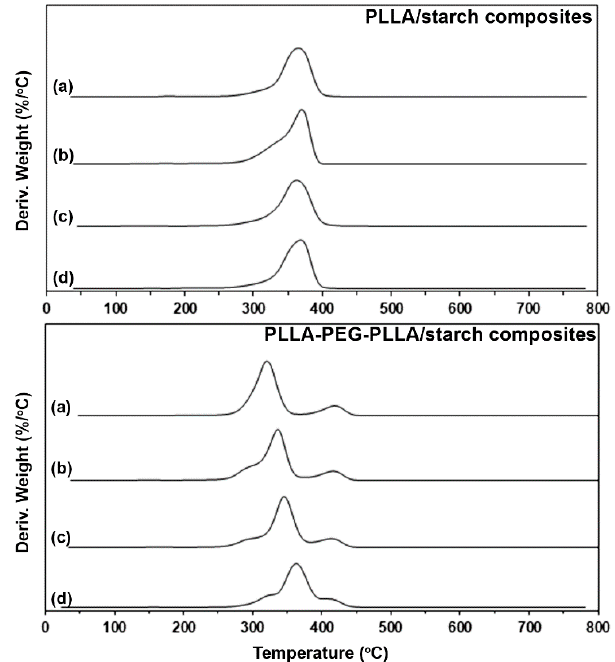
tained from TG thermograms at 800 ° C in Figure 3; c Temperature of maximum decomposition rate obtained from DTG thermograms in Figure 5; d Temperature of maximum decomposition rate for PEG blocks for PLLA blocks (PLLA-T d,max ) obtained from DTG thermograms in Figure 5; d Temperature of maximum (PEG-T d,max ) obtained from DTG thermograms in Figure 5. decomposition rate for PEG blocks (PEG-T d,max ) obtained from DTG thermograms in Figure 5.